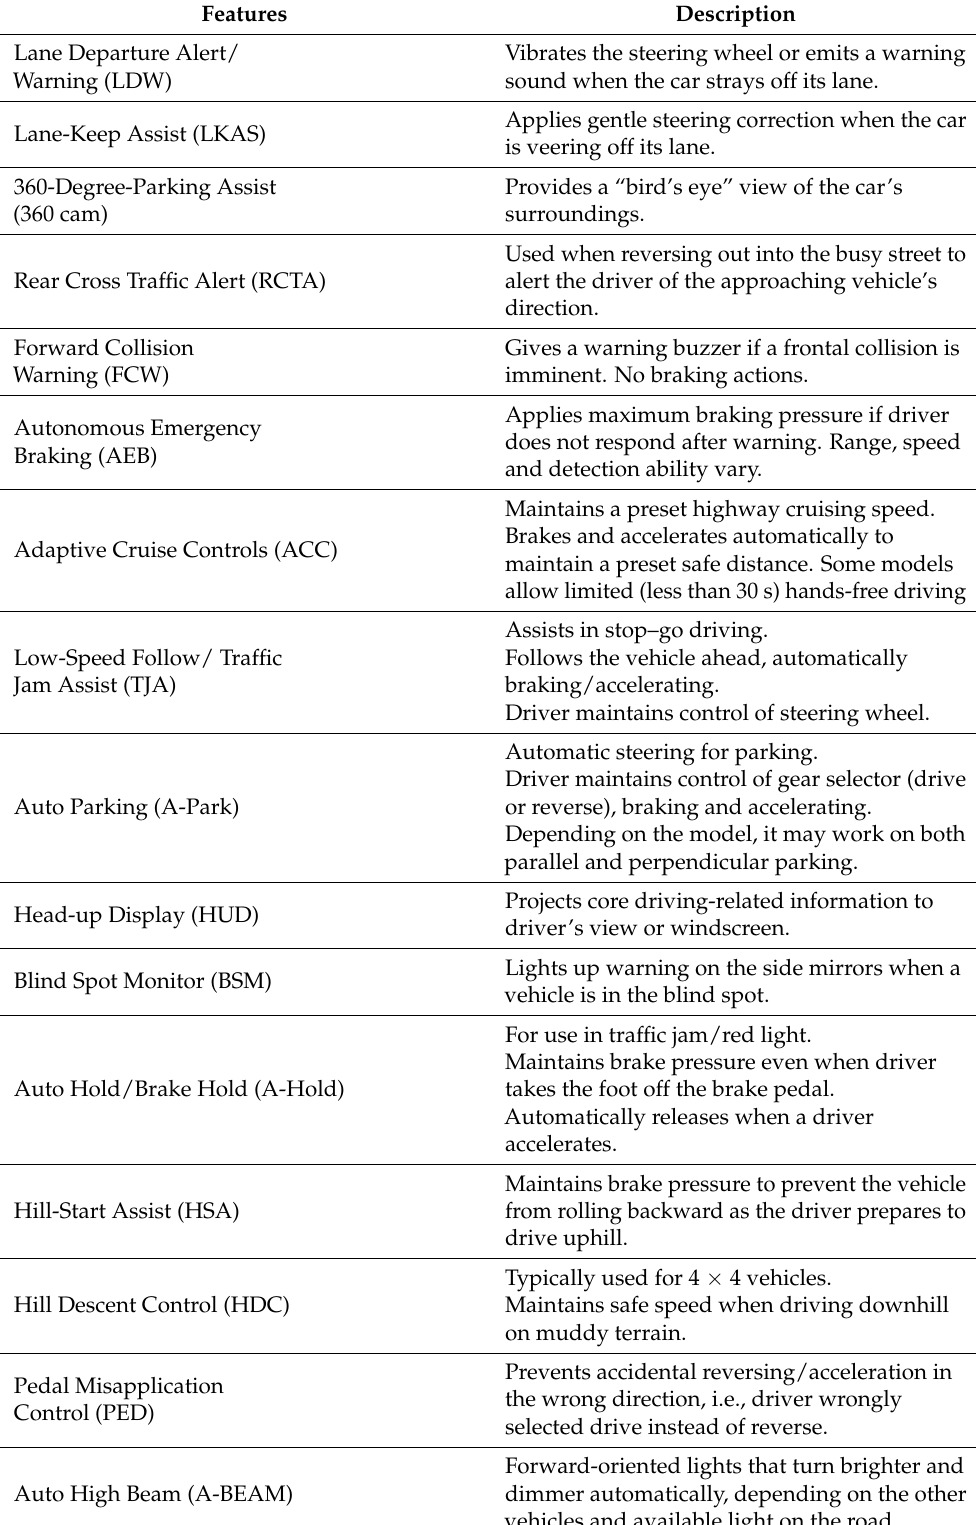
Table 1. In-vehicle